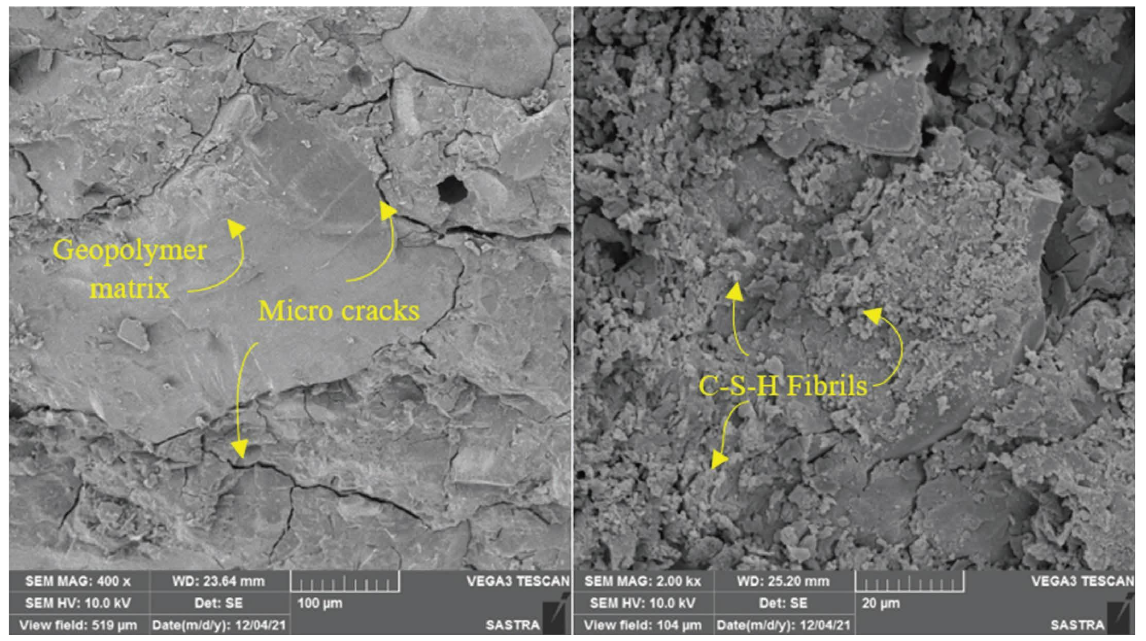
Figure 19: Scanning electron microscope of the geopolymer